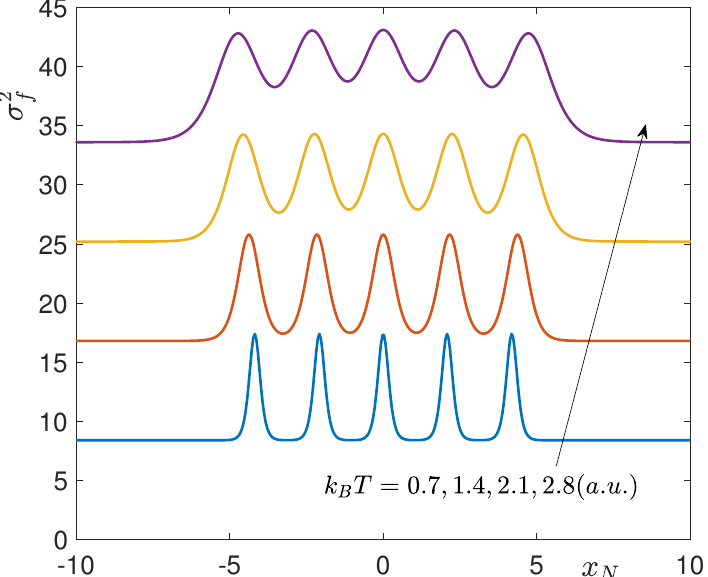
Figure 11. Variance of f obtained by the Helmholtz density (cid:36) H ( f ; x N ) . As before, we used N = 5, (cid:96) = 1 (a.u.), k = 15 (a.u.) and k B T = 0.7, 1.4, 2.1, 2.8